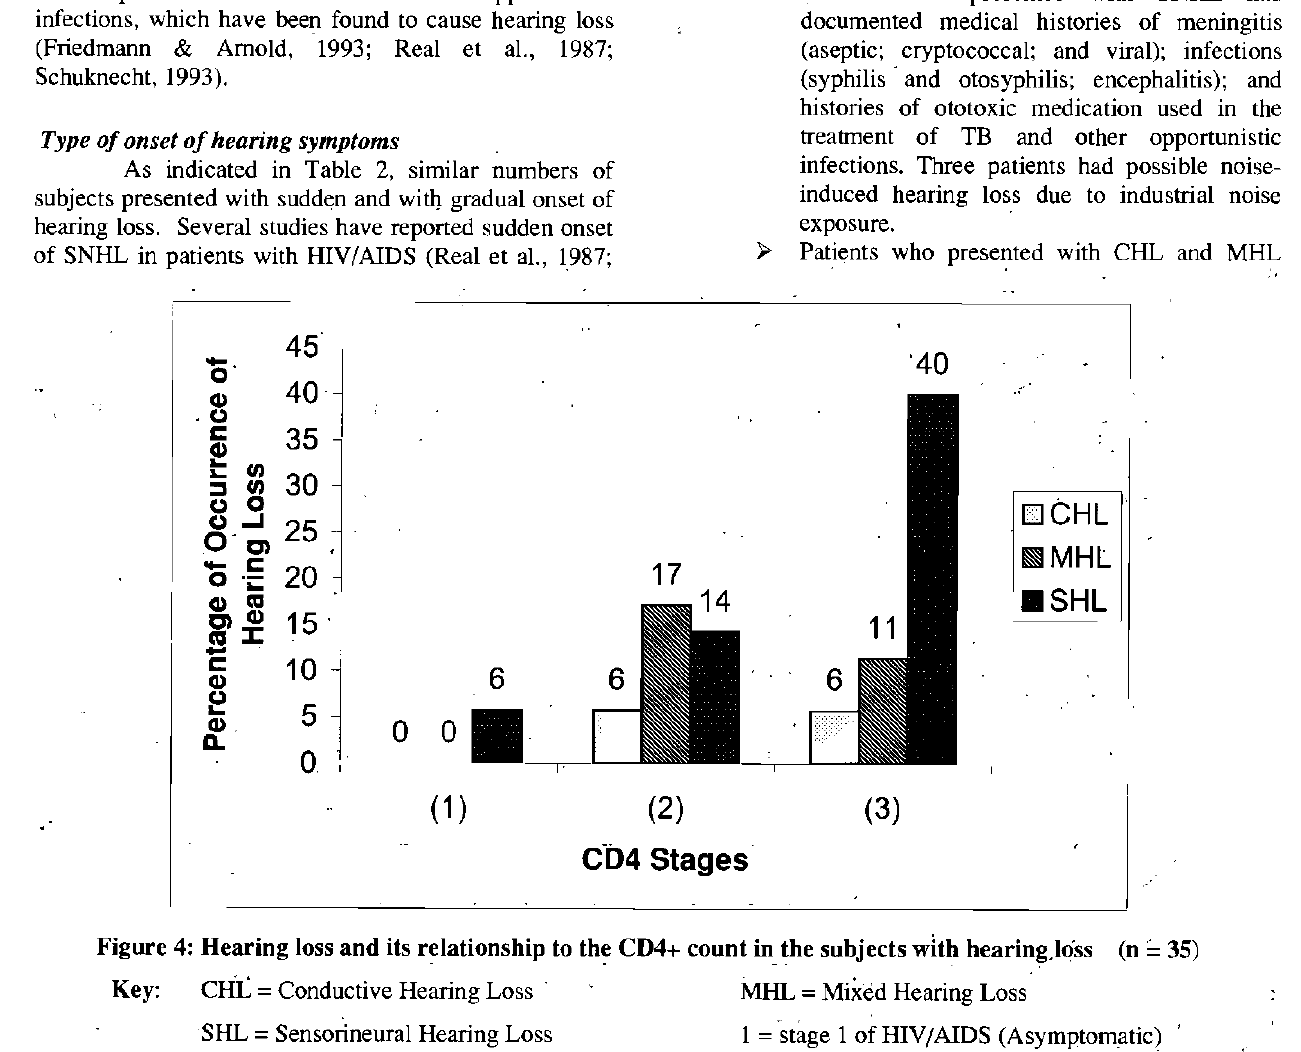
Figure 4: Hearing loss and its relationship to the CD4+ count in the subjects with hearing loss (n = 35) CHL = Conductive Hearing Loss ' MHL = Mixed Hearing Loss